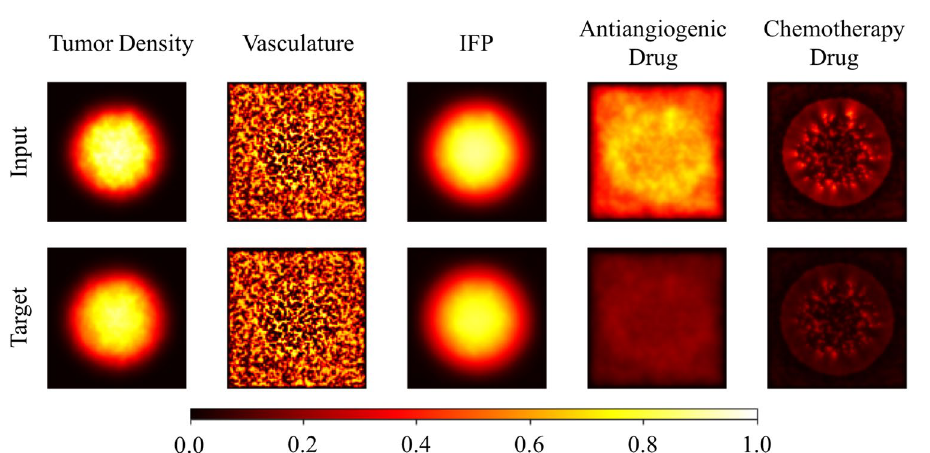
Figure 5. An example pair from the Elapser dataset is shown. The input and target tensors are presented in the first and second rows, respectively. Each tensor consists of five channels: tumor density, vasculature, IFP, antiangiogenic drug, and chemotherapy drug maps. The time interval between the input and the target tensor corresponds to one